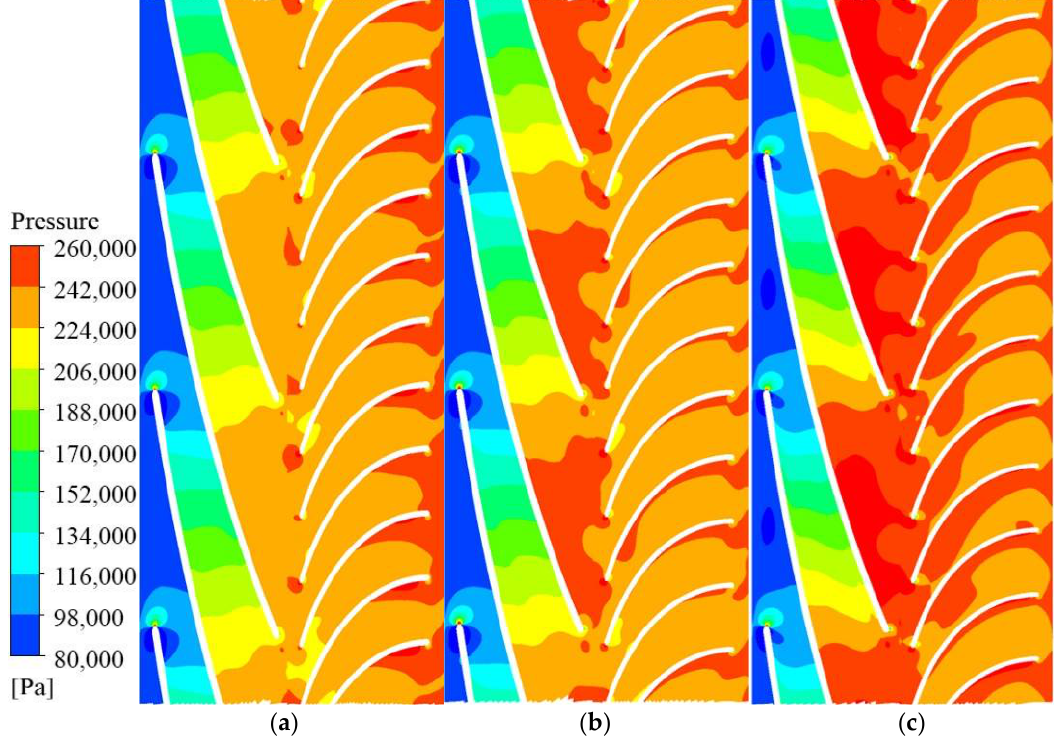
Figure 9. Pressure distribution in impeller and diffuser of different spans under GVF = 15%. ( a ) span = 0.1; ( b ) span = 0.5; ( c ) span = 0.9.